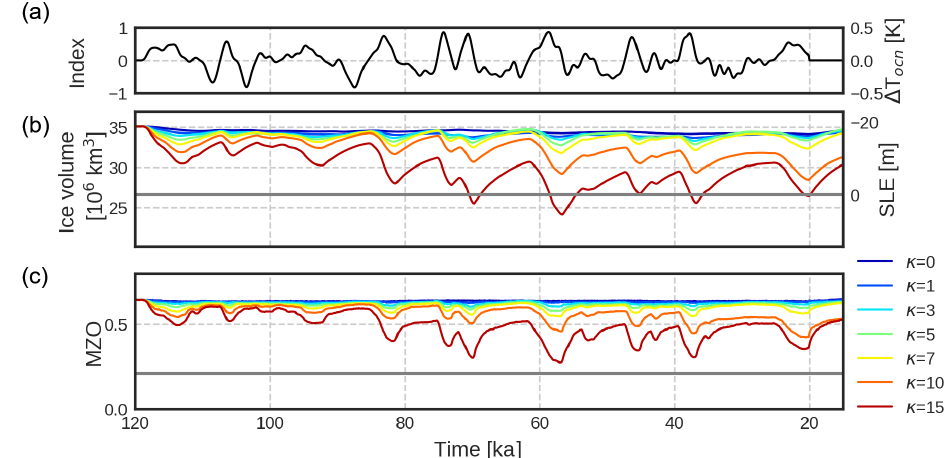
Figure 3. (a) Millennial-scale forcing index ( β ). On the right-hand side the equivalent oceanic temperature anomaly is shown (in K). (b) Ice volume (in 10 6 km 3 ) and SLE contribution (in m). (c) MZO evolution for different oceanic sensitivities. Colors go from no ice–ocean interaction ( κ = 0ma − 1 K − 1 , dark blue) to large oceanic sensitivity ( κ = 15ma − 1 K − 1 , red). The solid grey line in (b) and (c) indicates the present-day value of the ice volume and MZO, respectively.